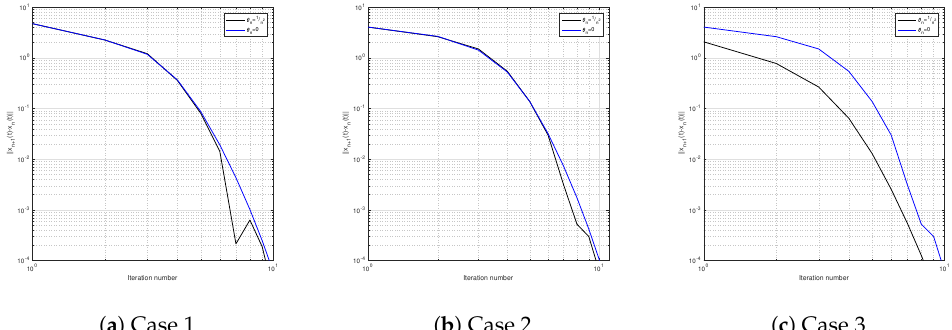
Figure 6. Cauchy error plots for the sequence { x n ( t ) } with and without the extrapolation factor ( θ n ) when (cid:36) n = 2.